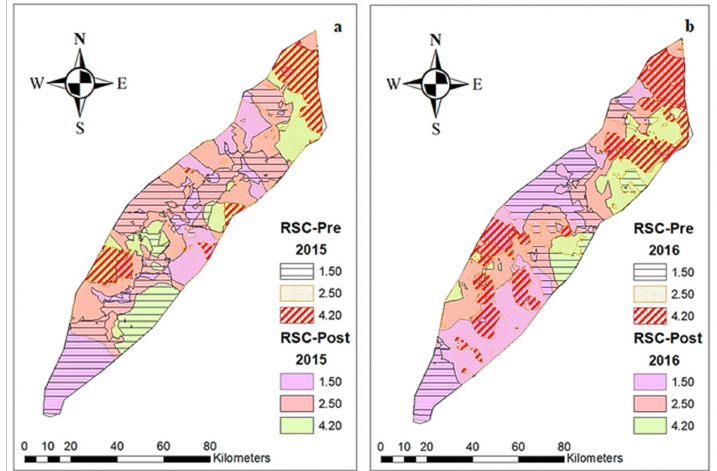
Figure 5. Overlay analysis of groundwater RSC. ( a ) RSC for 2015, ( b ) RSC for